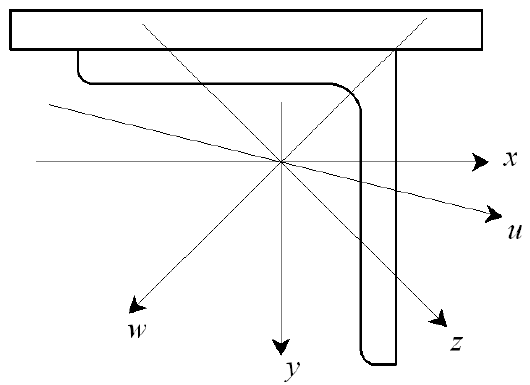
Figure 3: Instability axes of single angle